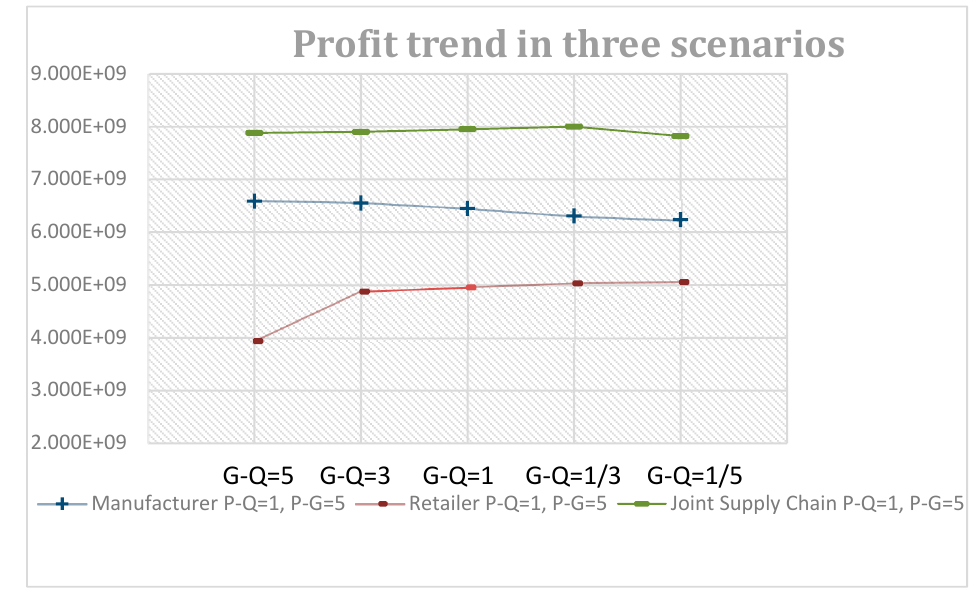
Figure 7. Profit trend of manufacturer, retailer, and joint supply chain when P-Q=1, P-G=5.